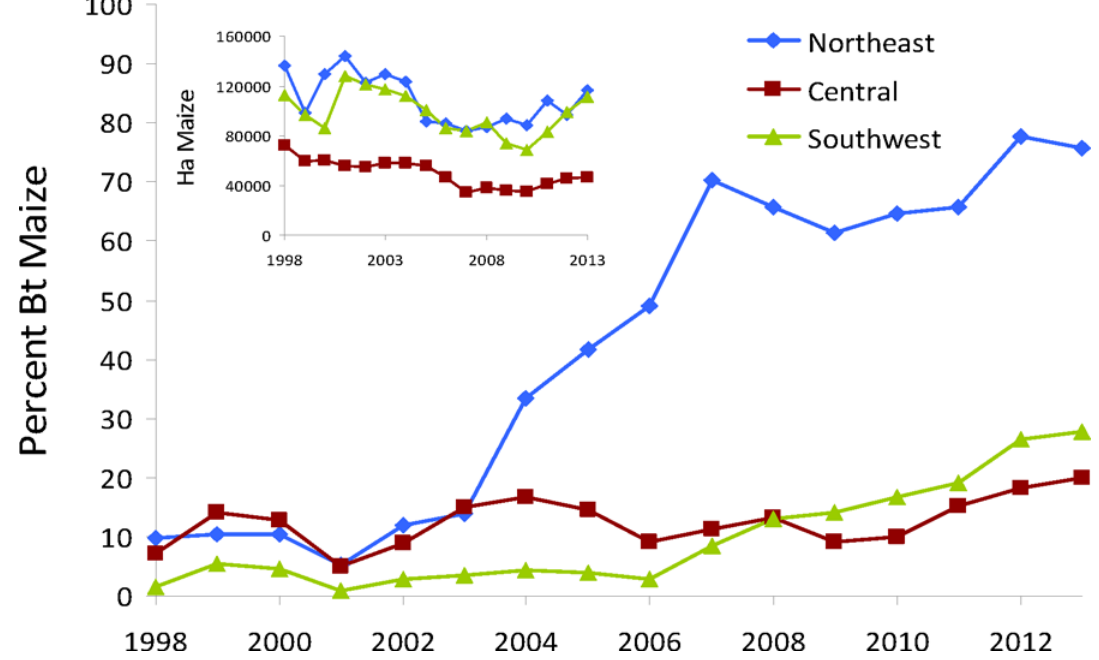
Fig 1. Adoption rate of Bt maize in the three main maize growing areas in Spain. Percentage of Bt maize in northeast (Catalu ñ a and Aragón), central (Madrid and Castilla-La Mancha) and southwest (Extremadura and Andalucía) Spain with respect to the total cultivated maize in each region (inner